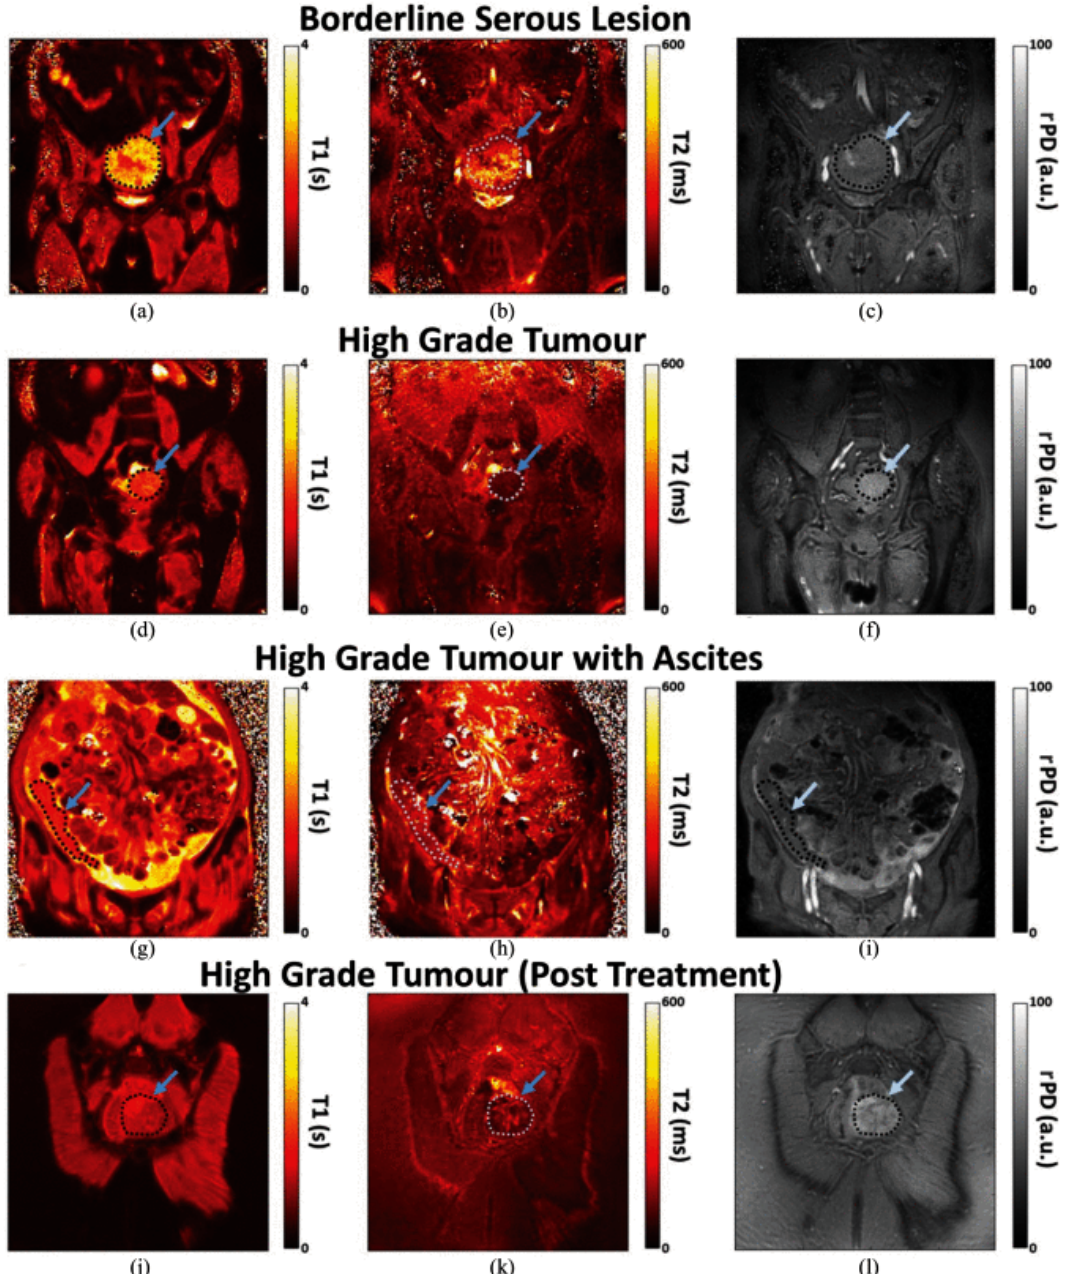
Figure 5. Coronal MRF T1, T2, and PD quantitative maps of the four patients with ( a – c ) borderline serous and ( d – l ) high grade tumours. Images ( a , b ) show areas of variation in tumoral signal intensities and hence possible disease heterogeneity. HGSOC tumours with ascites was visible on MRF images, arrowed regions on ( g – i ). One of the patients who had treatment response, MRF ( j – l ), was later confirmed to have no histological evidence of residual disease